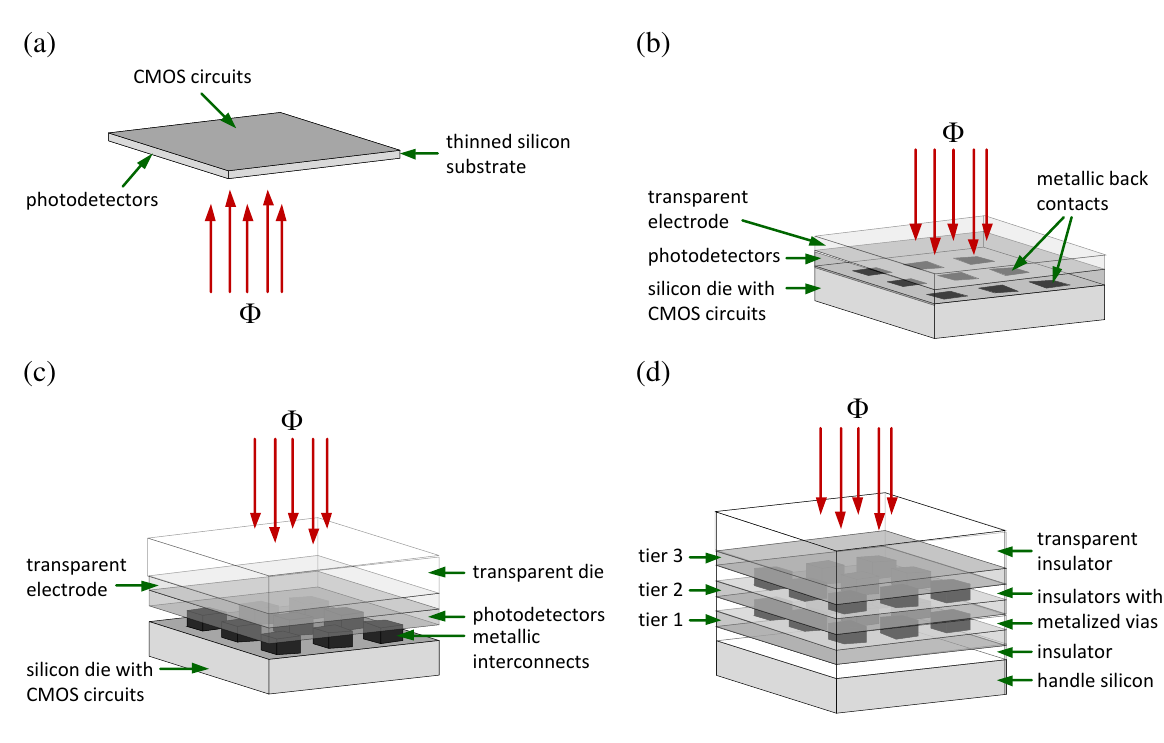
Figure 2. VI-CMOS image sensors fabricated by (a) thinned substrate, (b) thin-film- on-ASIC (TFA), (c) flip-chip, and (d) through-substrate via (TSV)